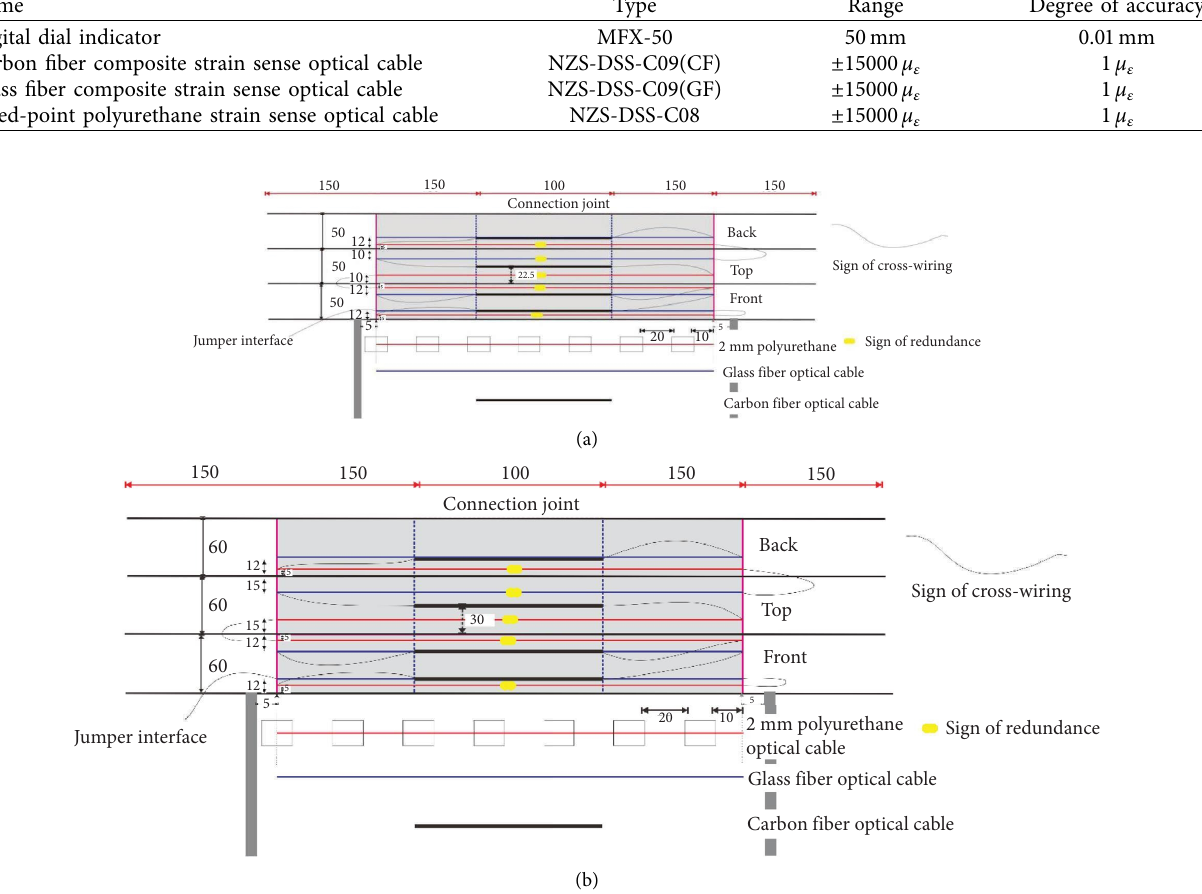
Figure 5: Actual layout of optical cable on the surface of CPCSP. (a) 500mm. (b)